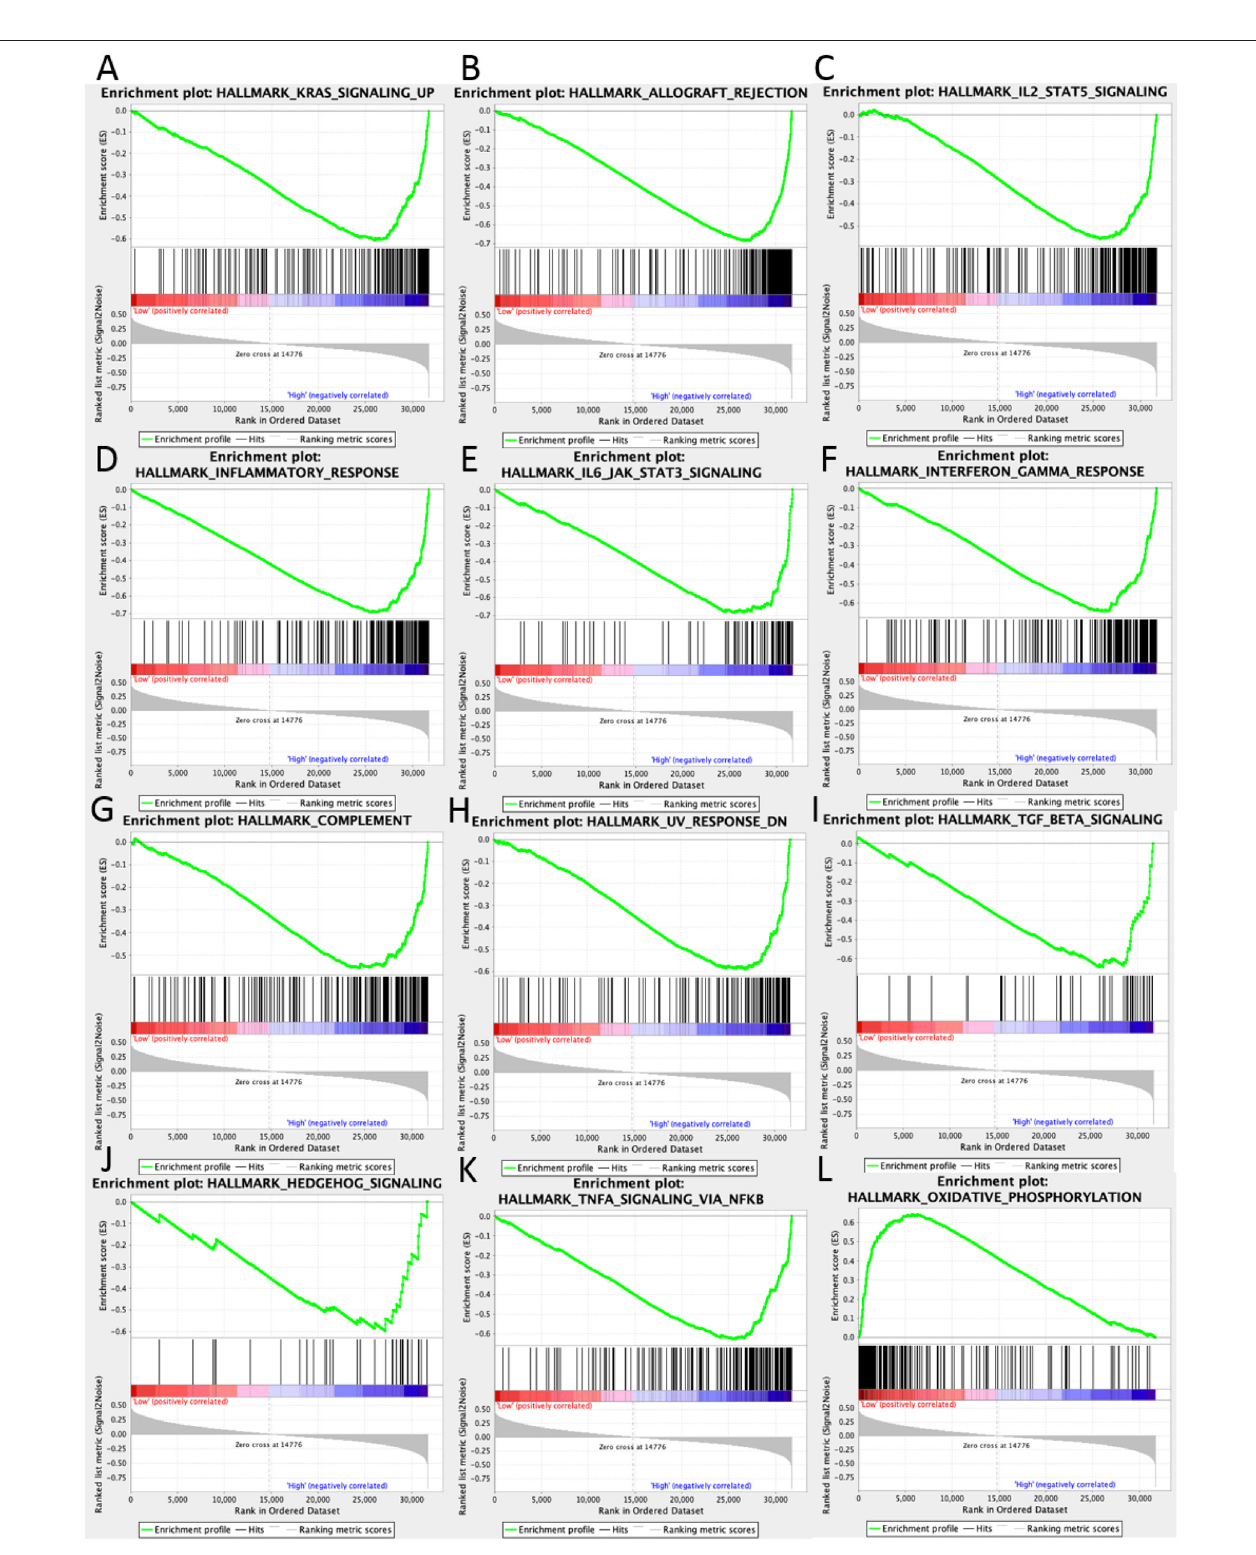
FIGURE 4 | GSEA pathways using single-gene method of UBASH3B. (A–K) Up-regulated gene sets in the group of high UBASH3B expression. (A) Enrichment plot: HALLMARK_KRAS_SIGNALING_UP. (B) Enrichment plot: HALLMARK_ALLOGRAFT_REJECTION. (C) HALLMARK_IL2_STAT5_SIGNALING. (D) Enrichment plot: